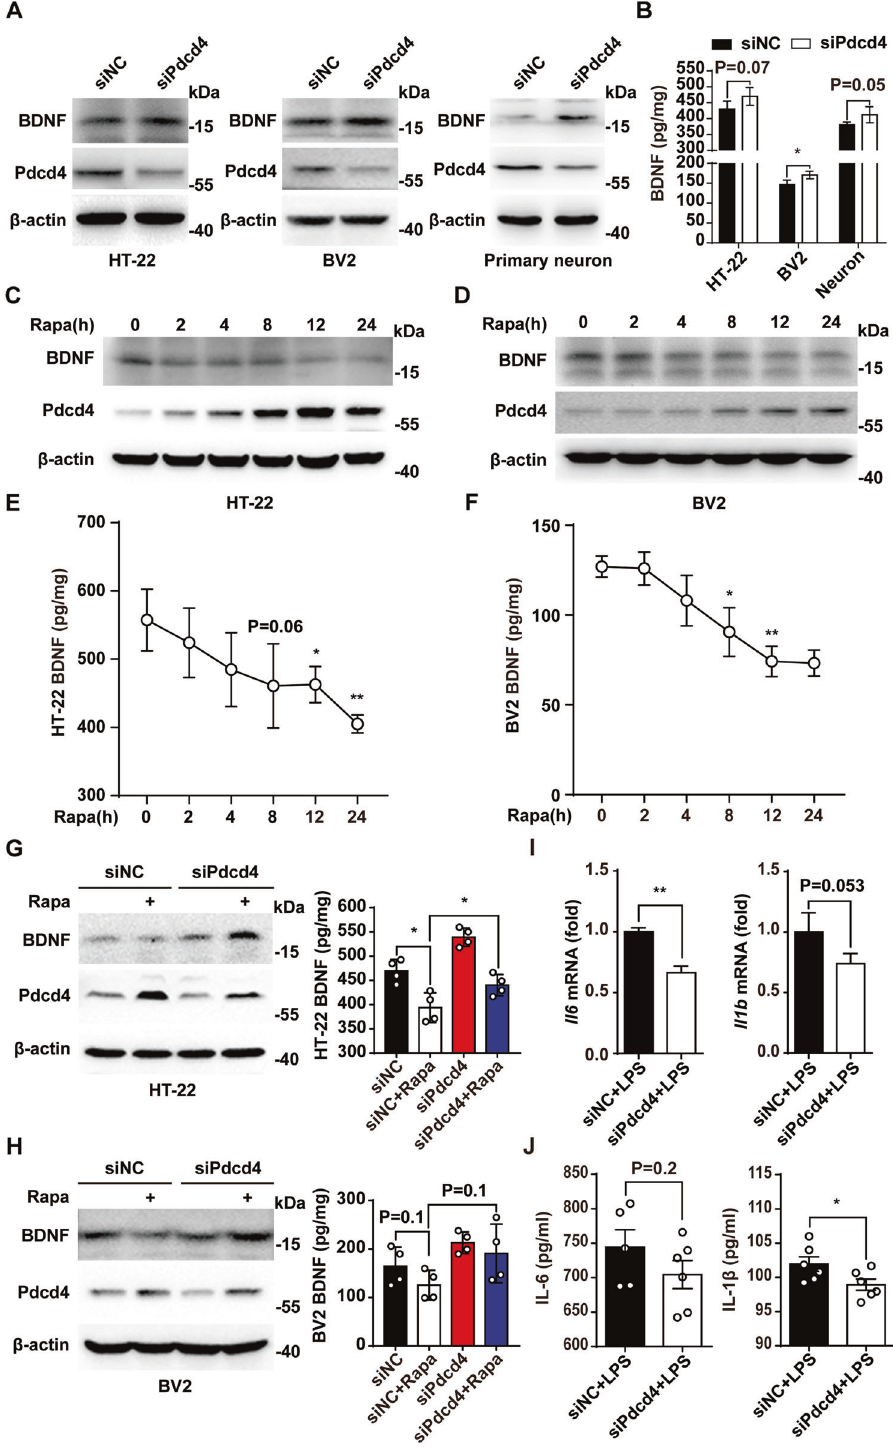
Fig. 3 RVG/siPdcd4 facilitates BDNF expression and suppresses in fl ammatory response. A , B RVG/siNC and RVG/siPdcd4 (100pM) were used to infect HT-22, BV2, and primary hippocampal neuron. After 24 h, the Pdcd4 and BDNF expression changes in cell lysis were measured by western blot and ELISA. C – F The mTORC1 speci fi c inhibitor rapamycin (200mM) were used to blocking mTORC1 activation in HT-22 and BV2 cells, and the changes of BDNF and Pdcd4 expression in different time points of cell were measured by western blot and ELISA ( n = 4 per group). G , H RVG/ siPdcd4 (100 pM) were used to slience HT-22 and BV2 Pdcd4 expression. After 24h, rapamycin (200 mM for 8h) was added to inhibit mTORC1 activation, and the expression changes of Pdcd4 and BDNF in cell were measured by western blot and ELISA ( n = 4 per group). I RVG/siPdcd4 (100 pM) was used to slience BV2 cells Pdcd4 expression. After 24h, lipopolysaccharide (10 ng/ml for 8h) and ATP (2.5mM for 40min) were used to stimulate the up-regulation of pro-in fl ammatory cytokines, and the mRNA changes of IL-6 and IL-1 β were measured by RT-PCR ( n = 3 per group). J The concentration of IL-6 (siNC + LPS n = 5, siPdcd4 + LPS n = 6) and IL-1 β ( n = 6 per group) in supernatant were measured by ELISA. Values are indicated as mean ±SD, Student ’ s t test * p < 0.05, ** p < 0.01. All the experiments were repeated at least three times